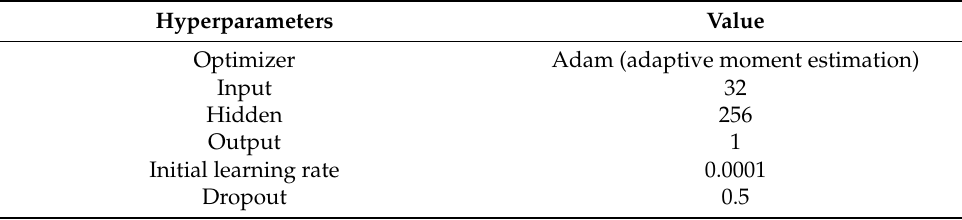
Table 2. Hyperparameters of BiLSTM.